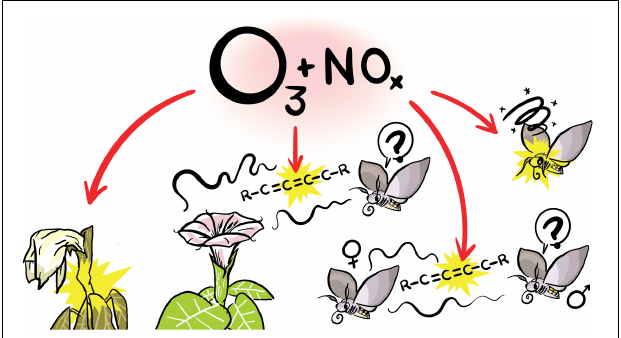
FIGURE 1 | Potential effects of pollutants like ozone and nitric oxides on plant and insects. Pollutants can cause direct oxidative physiological stress in plants and insects and can degrade volatiles involved in plant-insect and insect-insect communication. (Figure courtesy of Diego Galagovsky;